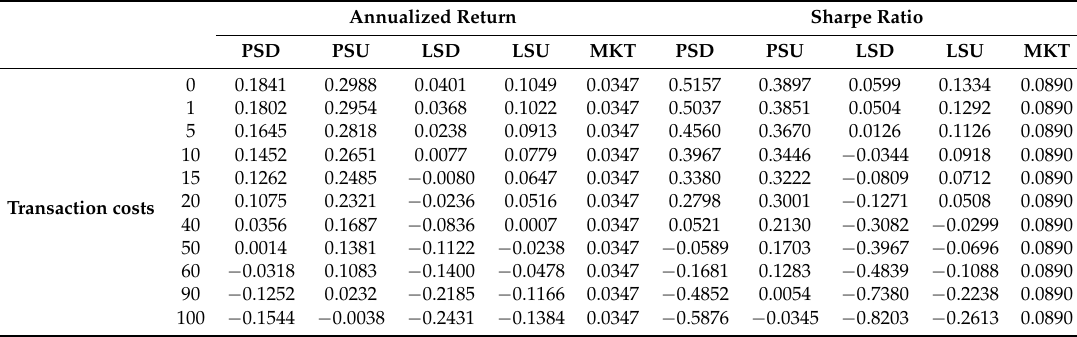
Table 5. Annualized mean return and Sharpe ratio for PSD, PSU, LSD, and LSU from January 2000 until December 2017 for different transaction costs per trade per straddle in